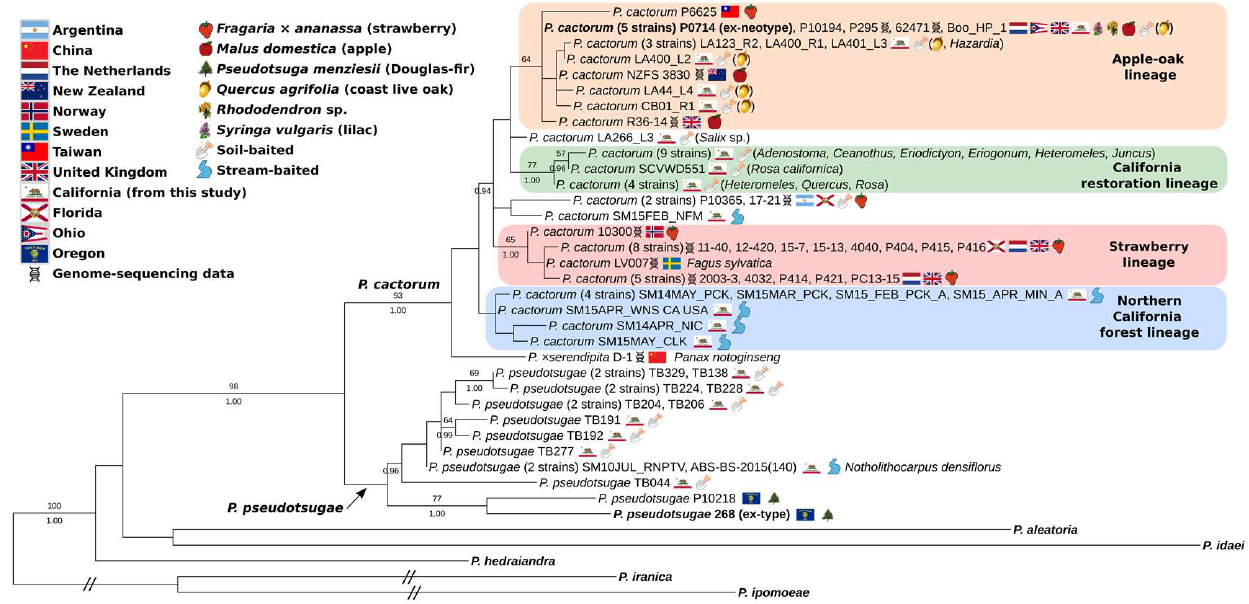
Figure 2. The 74-isolate, multi-locus maximum likelihood tree of Phytophthora subclade 1a. Tree inferred with IQTREE2 2.1.2 from ITS rDNA, mt cox2+spacer and mt cox1 loci, with a total of 2932 characters. Support values above branches are percentages ≥ 50 from 1000 non-parametric bootstrap replicates, and Bayesian posterior probabilities ≥ 0.90 from a separate analysis in MrBayes 3.2.7. Tree edited in TreeGraph2 and InkScape. Isolates on the same node were collapsed; slashes indicate branches that were artificially shortened for display purposes. Sequence accessions are listed in Table S1. When the shovel icon is followed by a host in parentheses, it indicates an isolate soil-baited from beneath that host.